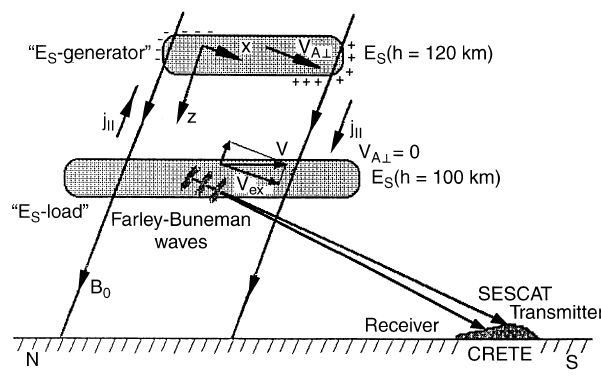
Fig. 2. Scheme to interpret the SESCAT experiment on the basis of the model E s generator– E s load: two sporadic layers are situated at di(cid:128)erent altitudes, for example, one layer is placed at the altitude h (cid:136) 120 km and the other lies at h (cid:136) 100 km. Optimal conditions for the generation of Farley-Buneman turbulence exist when the acoustic wave acts on the upper E s -layer ( E s generator) and the amplitude of the acoustic wave is large ( V A (cid:25) C s . In the lower layer ( E s load) the amplitude of the acoustic wave is small, V A (cid:25) 0)